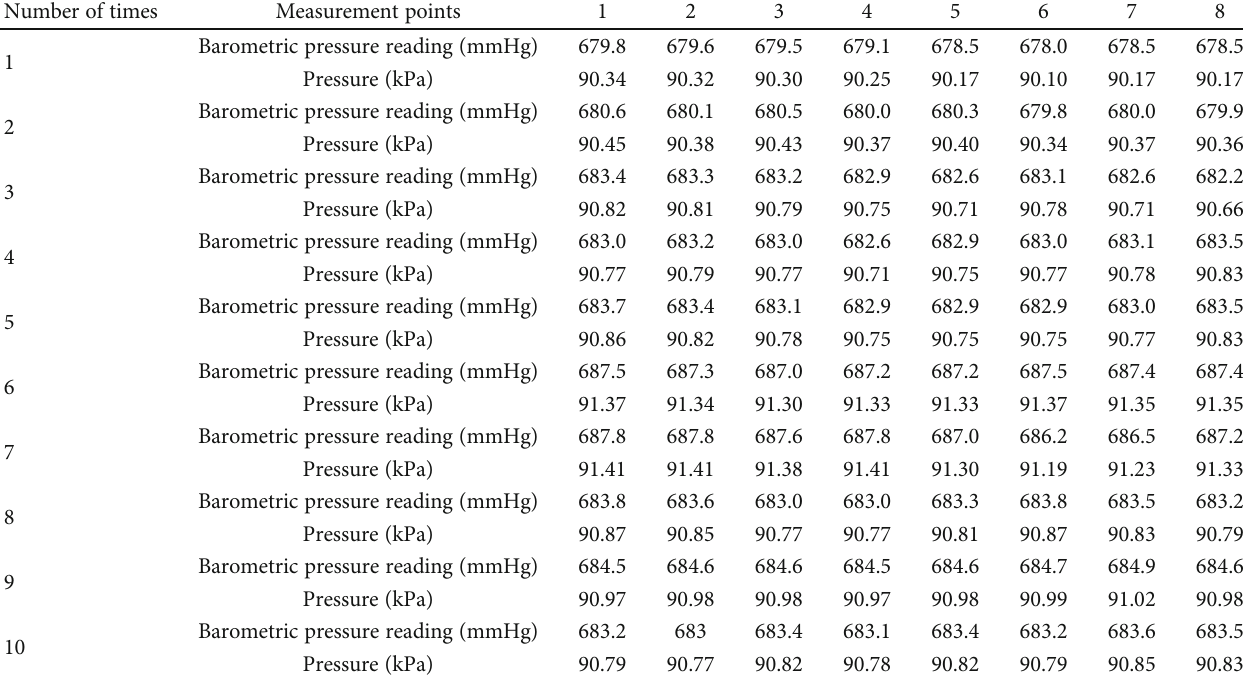
Table 2: Comprehensive table of air pressure observations at the working face. Number of times Measurement